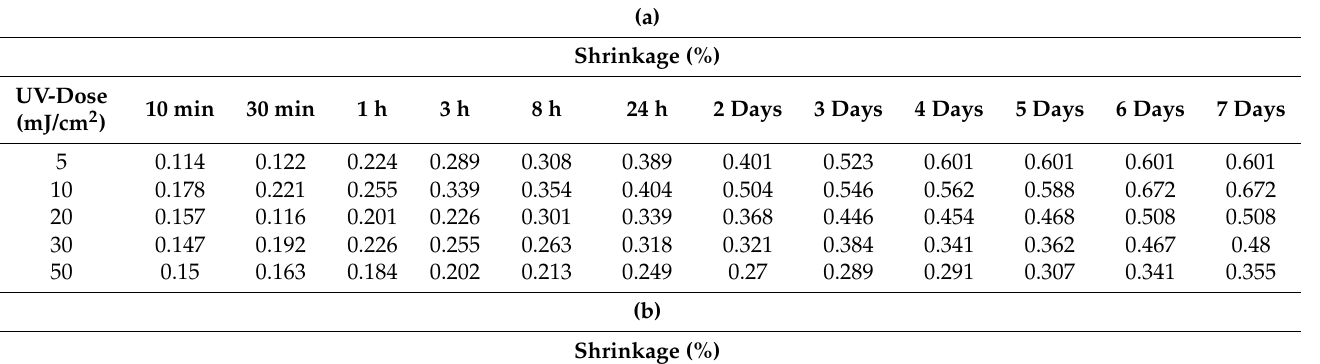
Table 4. Shrinkage of obtained copolymers depending on the dose of UV-C crosslinking ( a ) P1, ( b ) P2, and ( c ) P3. The measurement error was within the range of the statistical error.